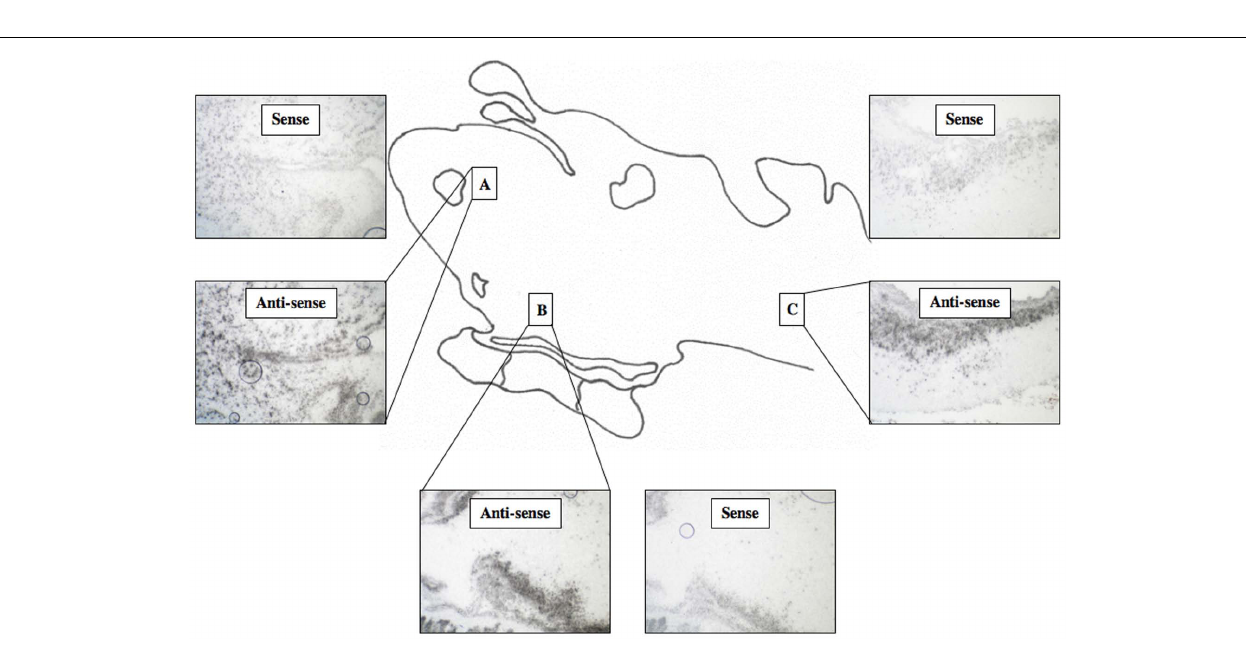
FIGURE 5 | 35 S-labeled In situ hybridization for lamprey ER. Light micrographs of sagittal tissue sections showing reaction product within the olfactory bulb (A) , the hypothalamus (B) , and the hindbrain (C) . (200 × mag).